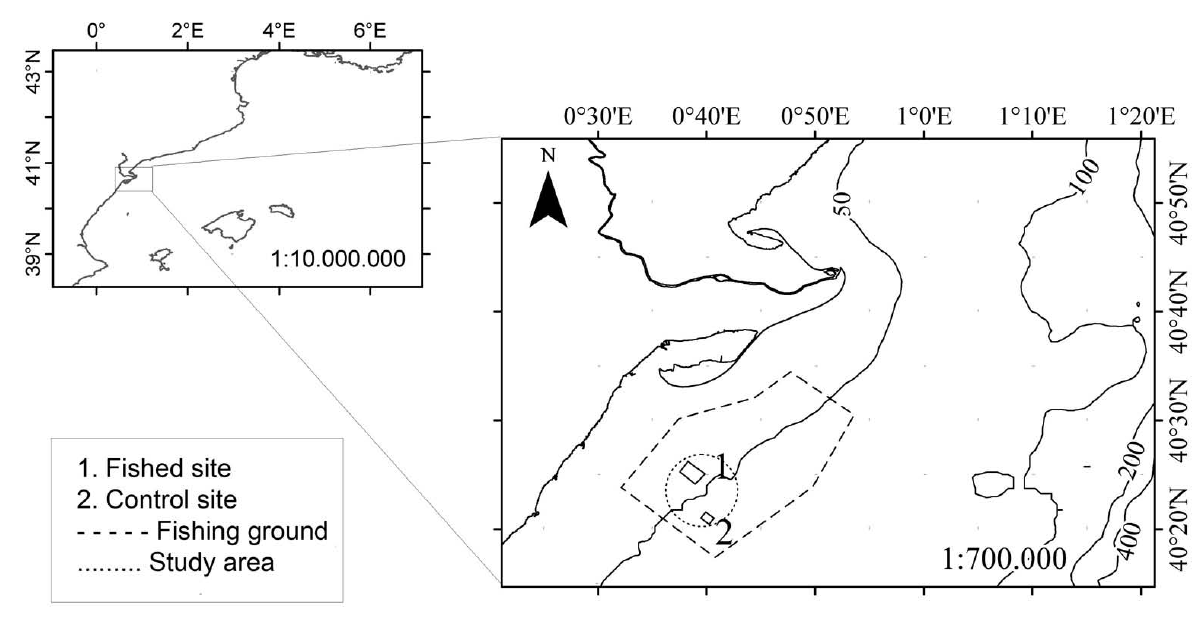
Fig. 2. – Location of the study area in the Catalan Sea off the Ebro Delta (northwestern Table 1. – Study area characterization over the sampling cruises. C, Control site; F, Fished site; %OM, organic matter percentage; %Mud, mud percentage on sediment; D50, mean grain size. Cruise